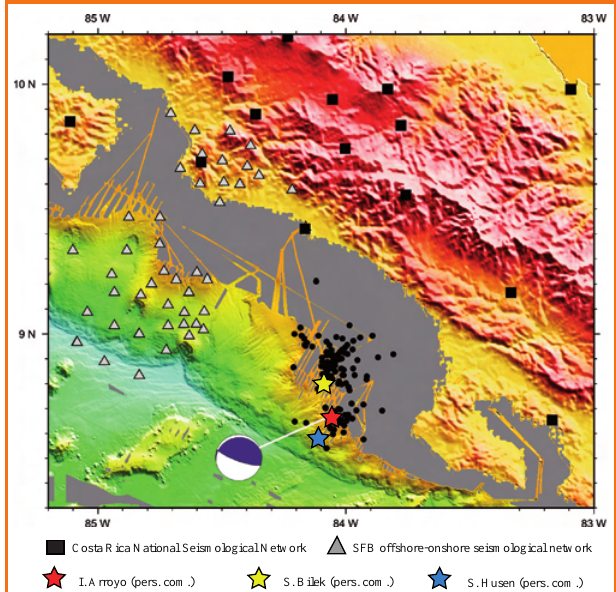
Figure 3. Location of the main shock and aftershocks of the 2002 Mw6.4 earthquake (red star). Triangles indicate the array of ocean bottom seismometers that recorded the quake; black squares are seismographs of the local network. Previous locations without the offshore seismograph array are shown in yellow and blue